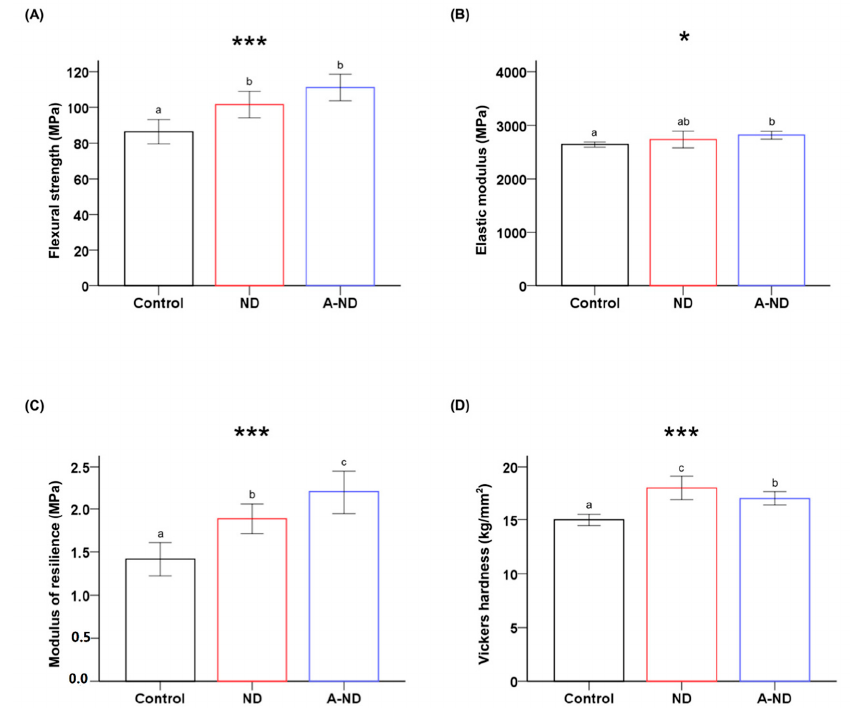
Figure 8. Comparing the ( A ) flexural strengths; ( B ) elastic moduli; ( C ), moduli of resilience; ( D ) Vickers hardness of the various groups of samples after exposure to hydro-thermal fatigue. Different lowercase letters indicate significant differences. ** p < 0.01, *** p < 0.001. Table 2. Mean and standard deviation values of flexural strength, elastic modulus, modulus of resilience and Vickers microhardness for different groups after thermocycling.